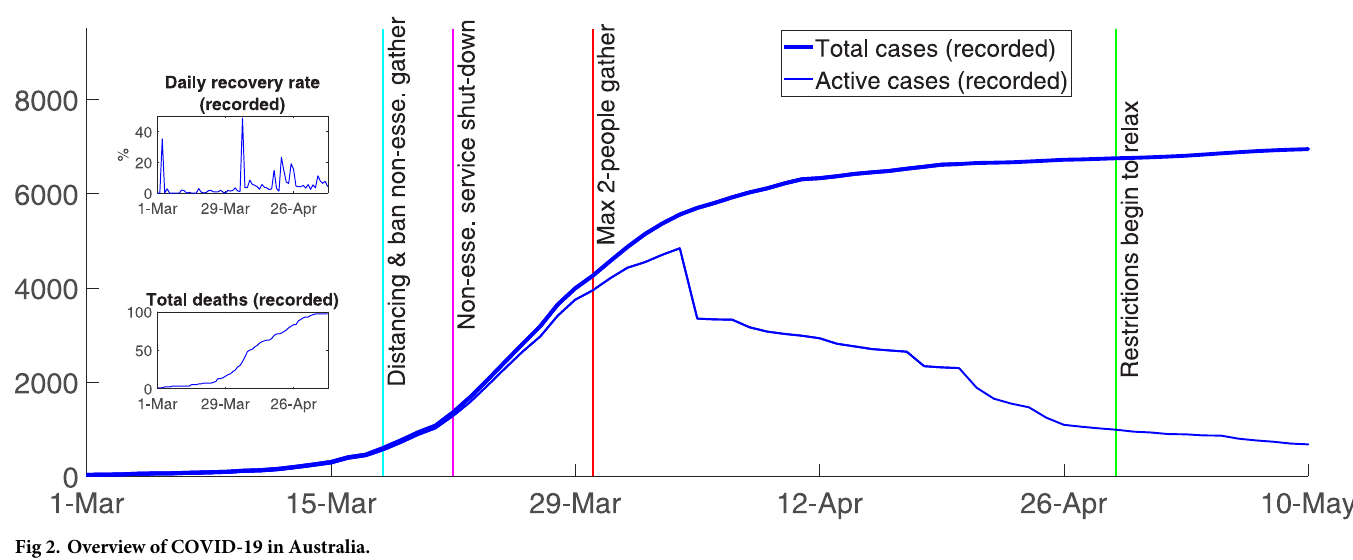
munity transmission of the virus and the daily growth rate (the daily increase in the total num- ber of cases over the total number of cases, on a three-day average) declined from around 25%, with 268 new recorded cases on 22 nd March, to a daily growth rate of 0.26% and 11 new recorded cases on 30 th May 2020 [5].